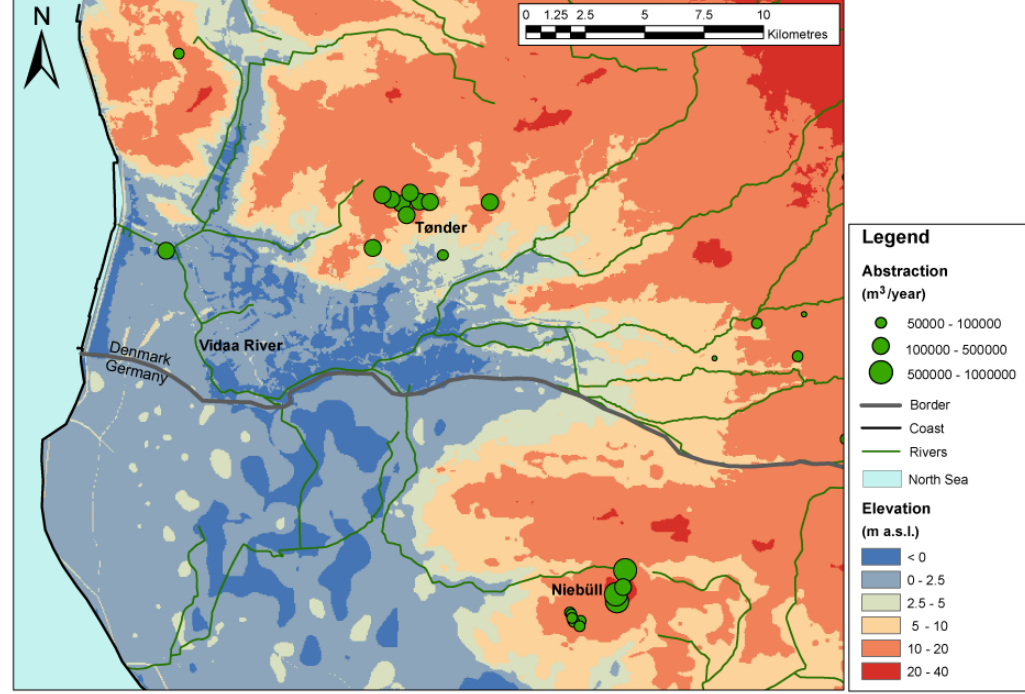
Fig. 2. Land surface elevation in metres above sea level (ma.s.l.), drainage system and groundwater